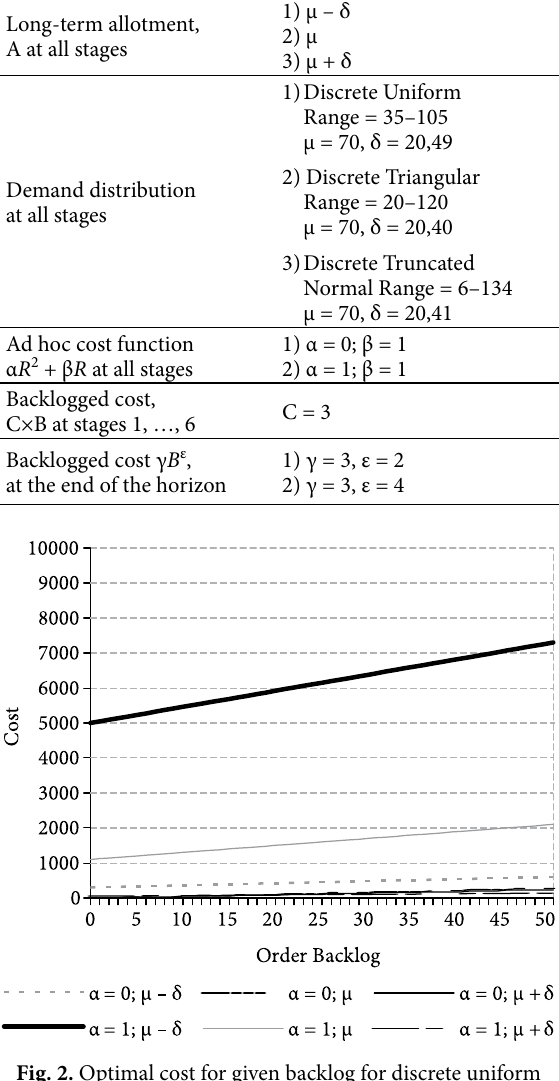
Fig. 2. Optimal cost for given backlog for discrete uniform demand and backlogged cost 3 B 2